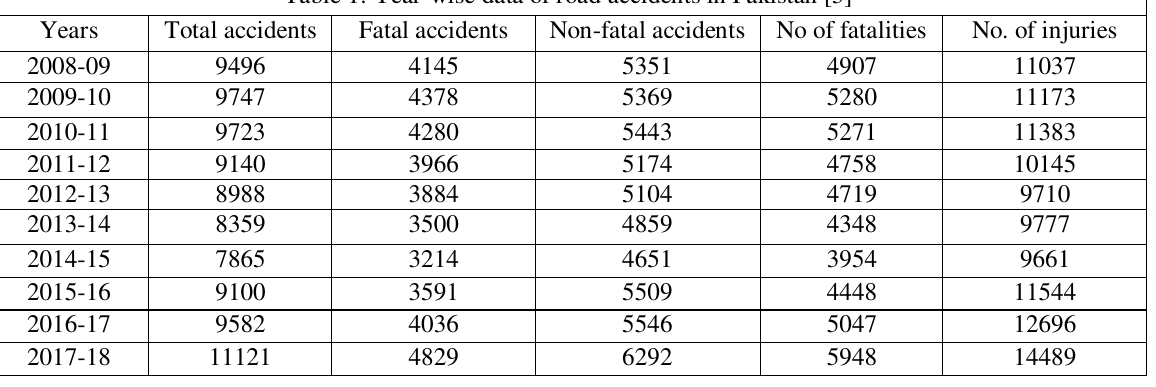
Table 1: Year-wise data of road accidents in Pakistan